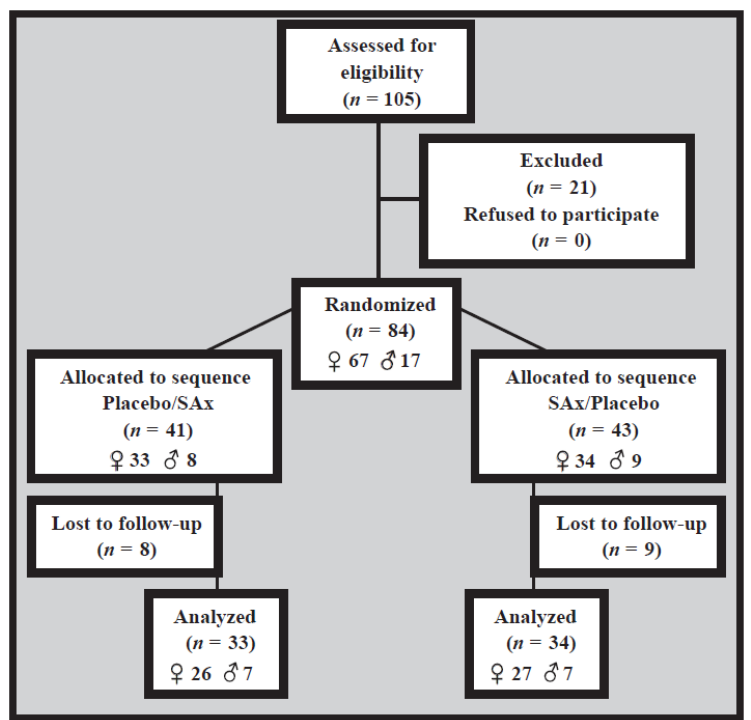
Figure 1. Flow chart depicting the present study.